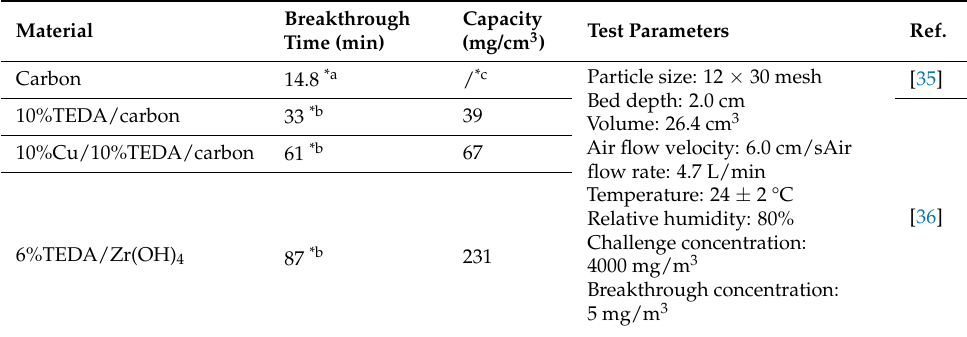
Table 1. CNCl capacities of different